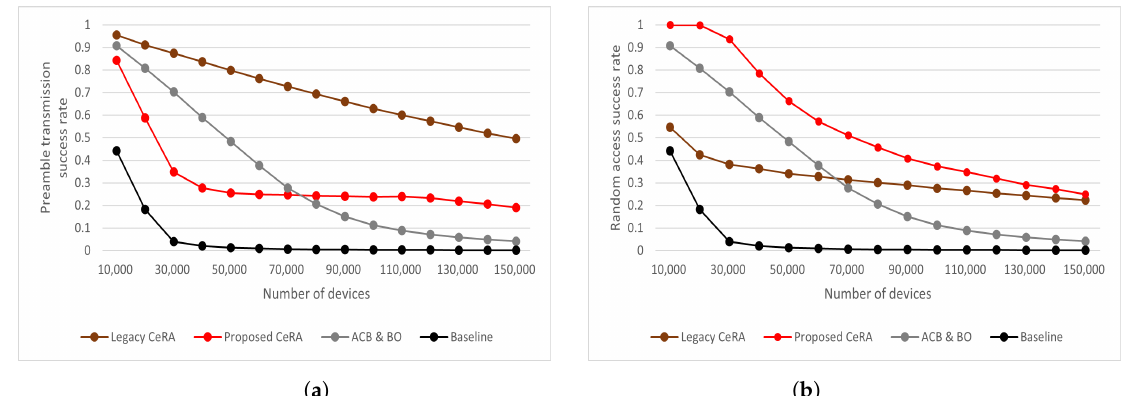
Figure 9. ( a ) Successful preamble transmission rate for different numbers of devices and ( b ) Successful random access rate for different numbers of devices